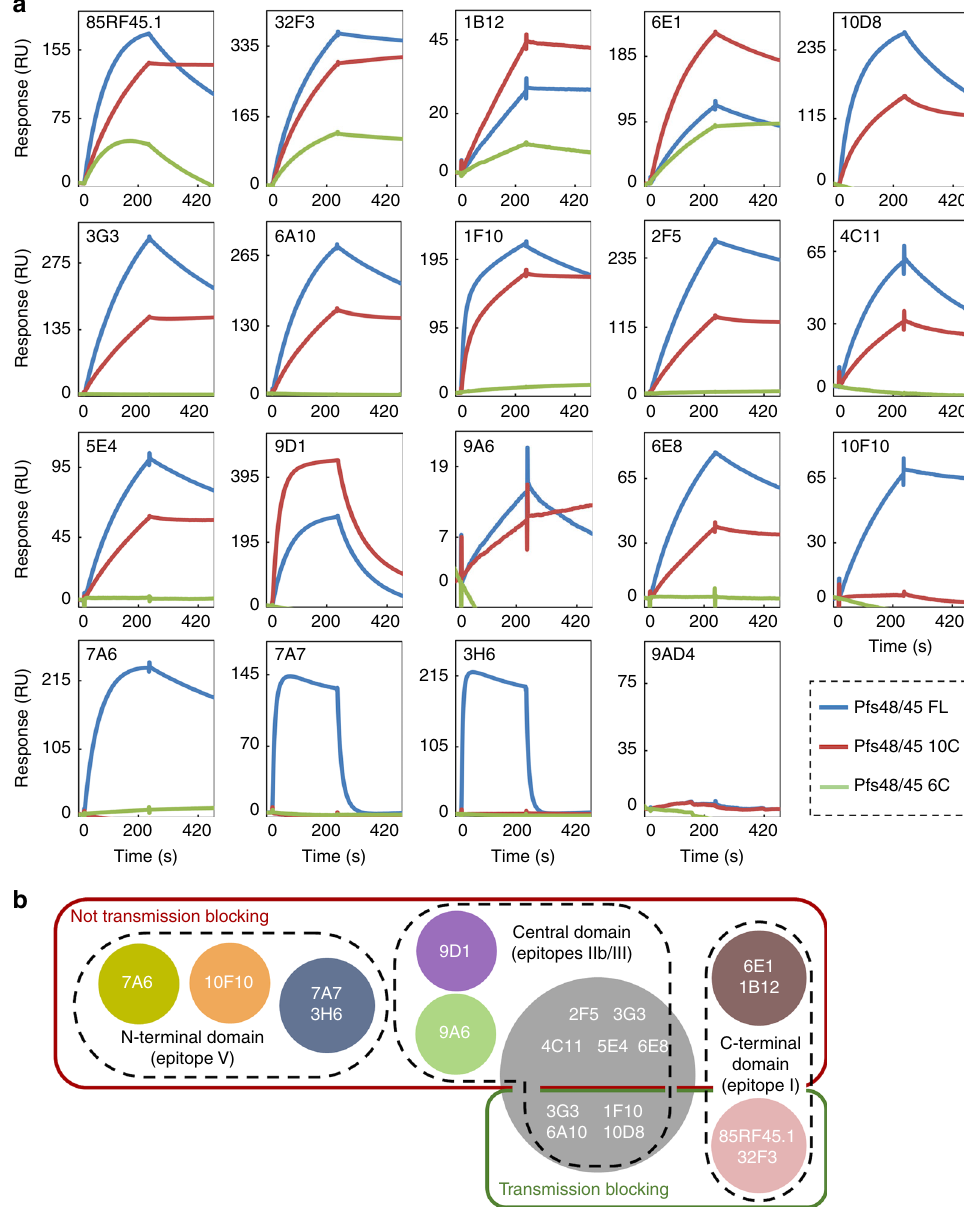
Fig. 3 Mapping of anti-Pfs48/45 antibodies binding to different Pfs48/45 subdomains. a The indicated mAbs were immobilised on a Protein A/G chip at fi xed concentration. Pfs48/45 FL (blue lines), Pfs48/45-10C (red lines) or Pfs48/45-6C (green lines) were then injected over the chip surface at fi xed concentration. 9AD4 is a control antibody reactive against PfRH5. b Summary of epitope mapping experiments. Circles indicate the different competition groups among the mAbs, as shown in Fig. 2. mAbs are further grouped into transmission-blocking and non-transmission-blocking mAbs by green and red outlines, respectively. Black dashed outlines show which mAbs bind to the N-terminal, central (10C) or C-terminal (6C) domain. Previously de fi ned epitopes I – V 6 , for anti-Pfs48/45 antibodies, are